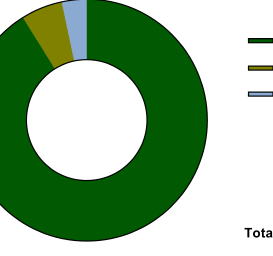
Figure 7. B1 building non-prefabricated simulation method transportation and construction phase carbon emissions.